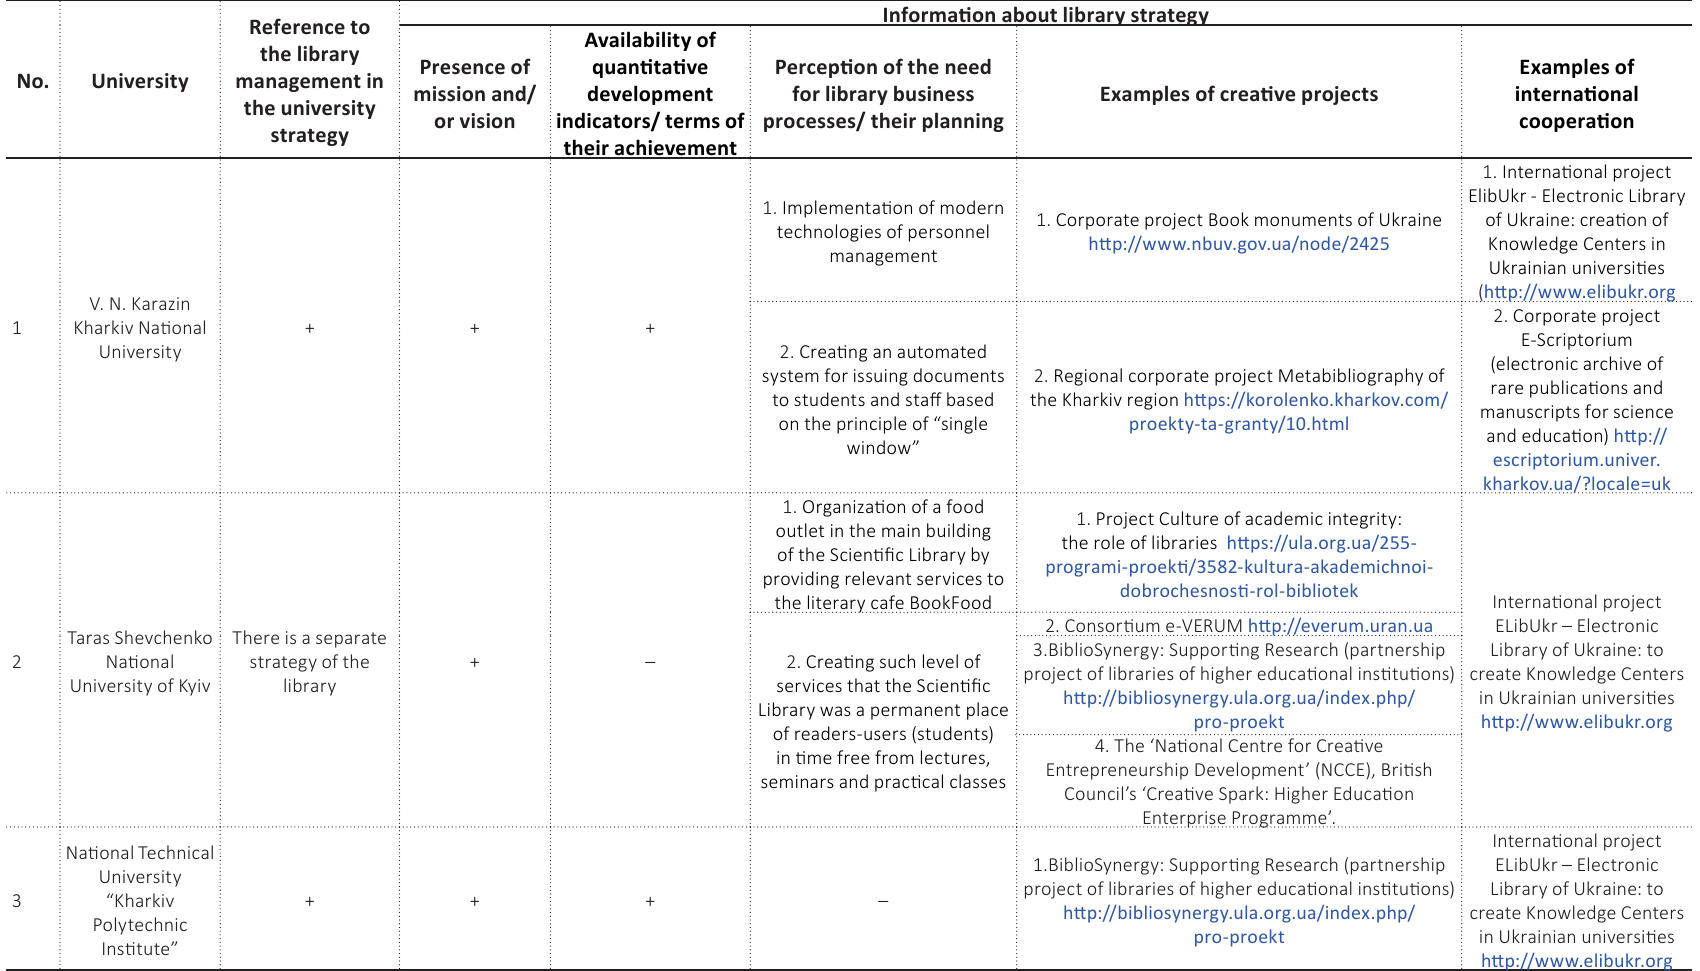
Table B1. Analysis of strategies of university libraries